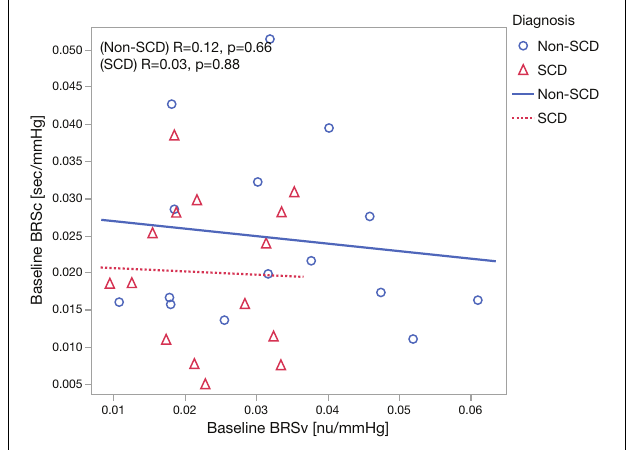
FIGURE 1 | Relationship between baseline BRSv and baseline BRSc in non-SCD and SCD